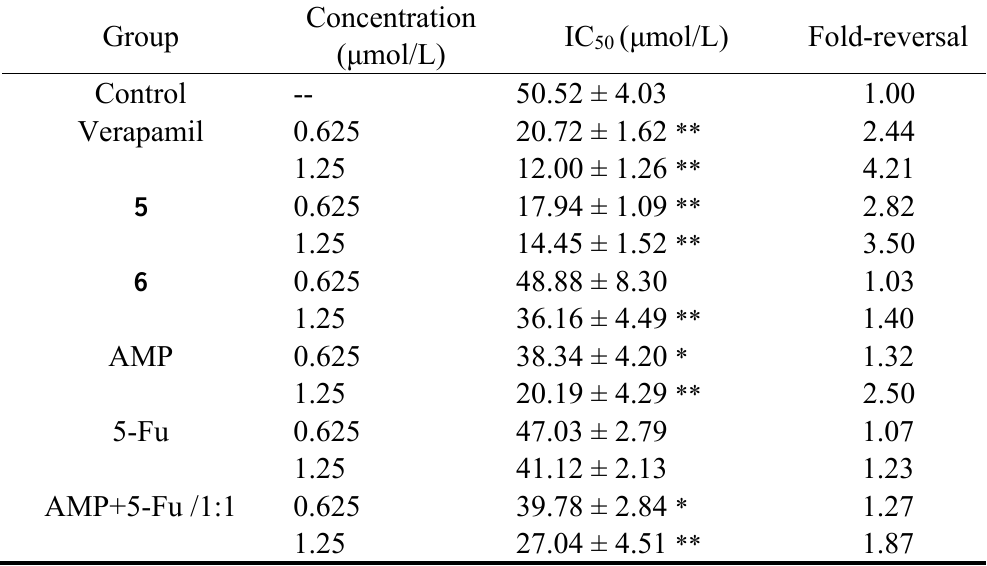
Table 2. Reversal effect of 5 and 6 on multidrug resistance in K562/ADR cells for 48